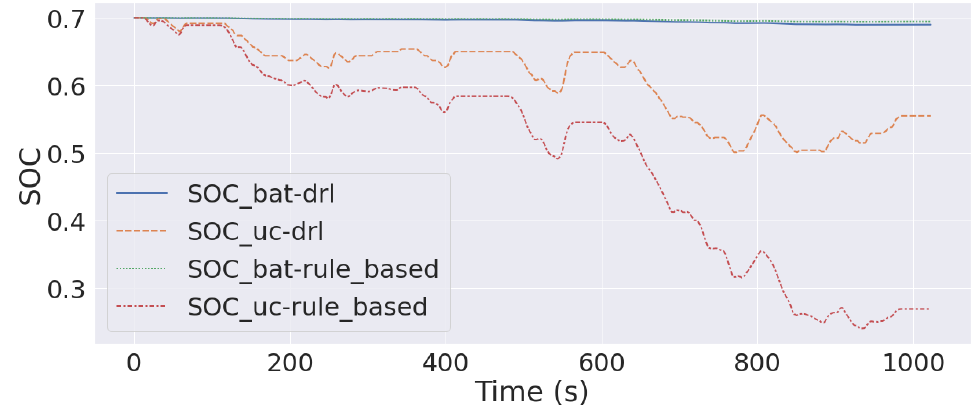
Figure 14. Comparison of SOCs obtained by rule-based and DRL techniques when the initial SOCs are 0.7.